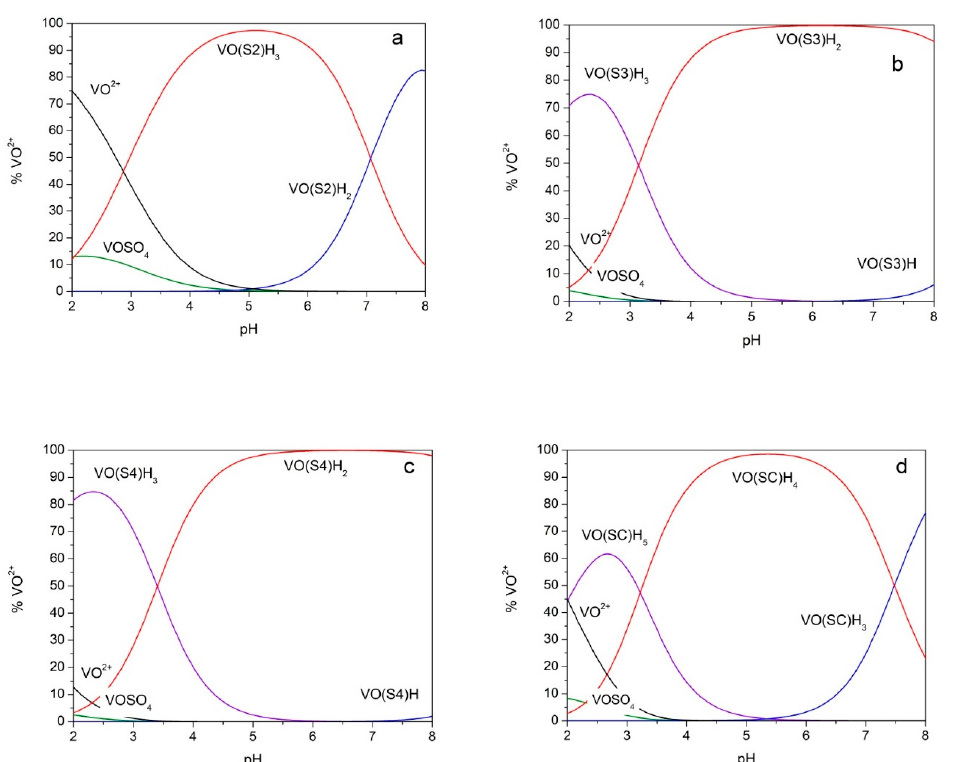
Figure 3. Species distribution diagrams. Species distribution diagrams for solutions of oxovanadium(IV) 5 mmolL − 1 and ligand 10 mmol L − 1 calculated on the basis of the formation constants reported in Table 1. ( a ) ligand = S2; ( b ) ligand = S3; ( c ) ligand = S4; ( d ) ligand = SC. VOSO 4 : Vanadyl–sulphate ion